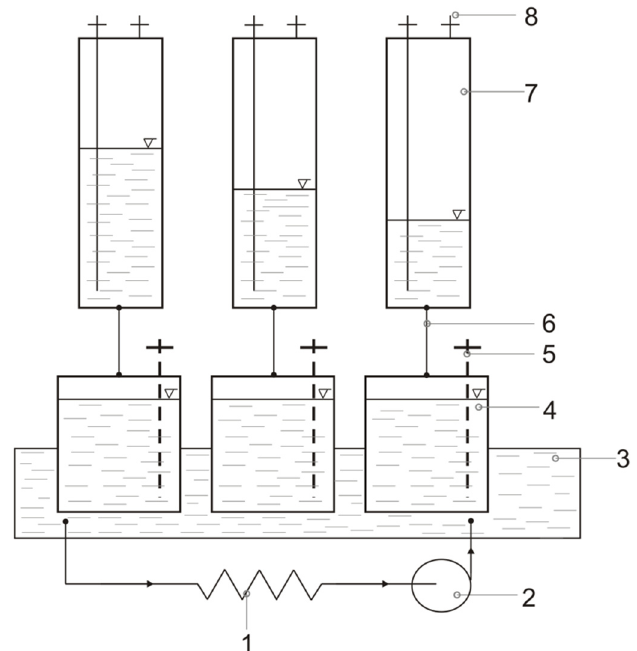
Figure 1. A diagram of the digester used for biogas production: (1) water heater with a temperature controller within 20–70 °C; (2) water pump; (3) water jacket with a temperature of 39 °C ± 1 °C; (4) biodigester with a capacity of 2 dm 3 ; (5) stub pipe for sampling the biogas mixture; (6) pipe for